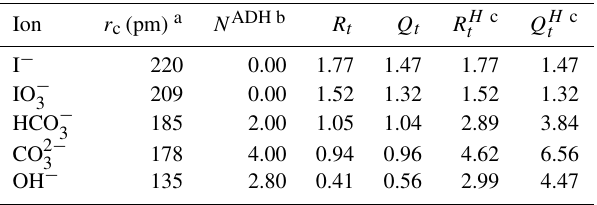
Table 1. Physical properties of the new ions introduced in the study.